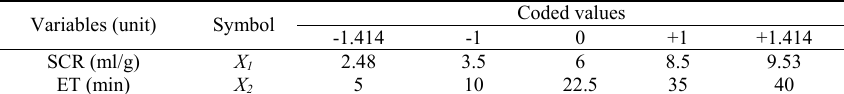
Table 4: Coded levels and variables in the main experiments